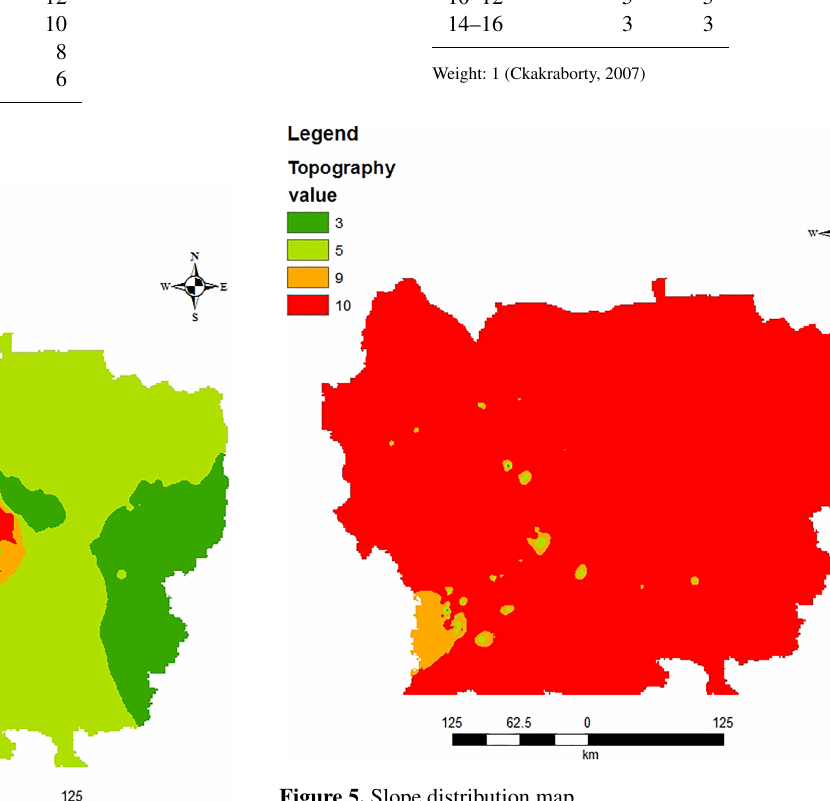
Figure 5. Slope distribution